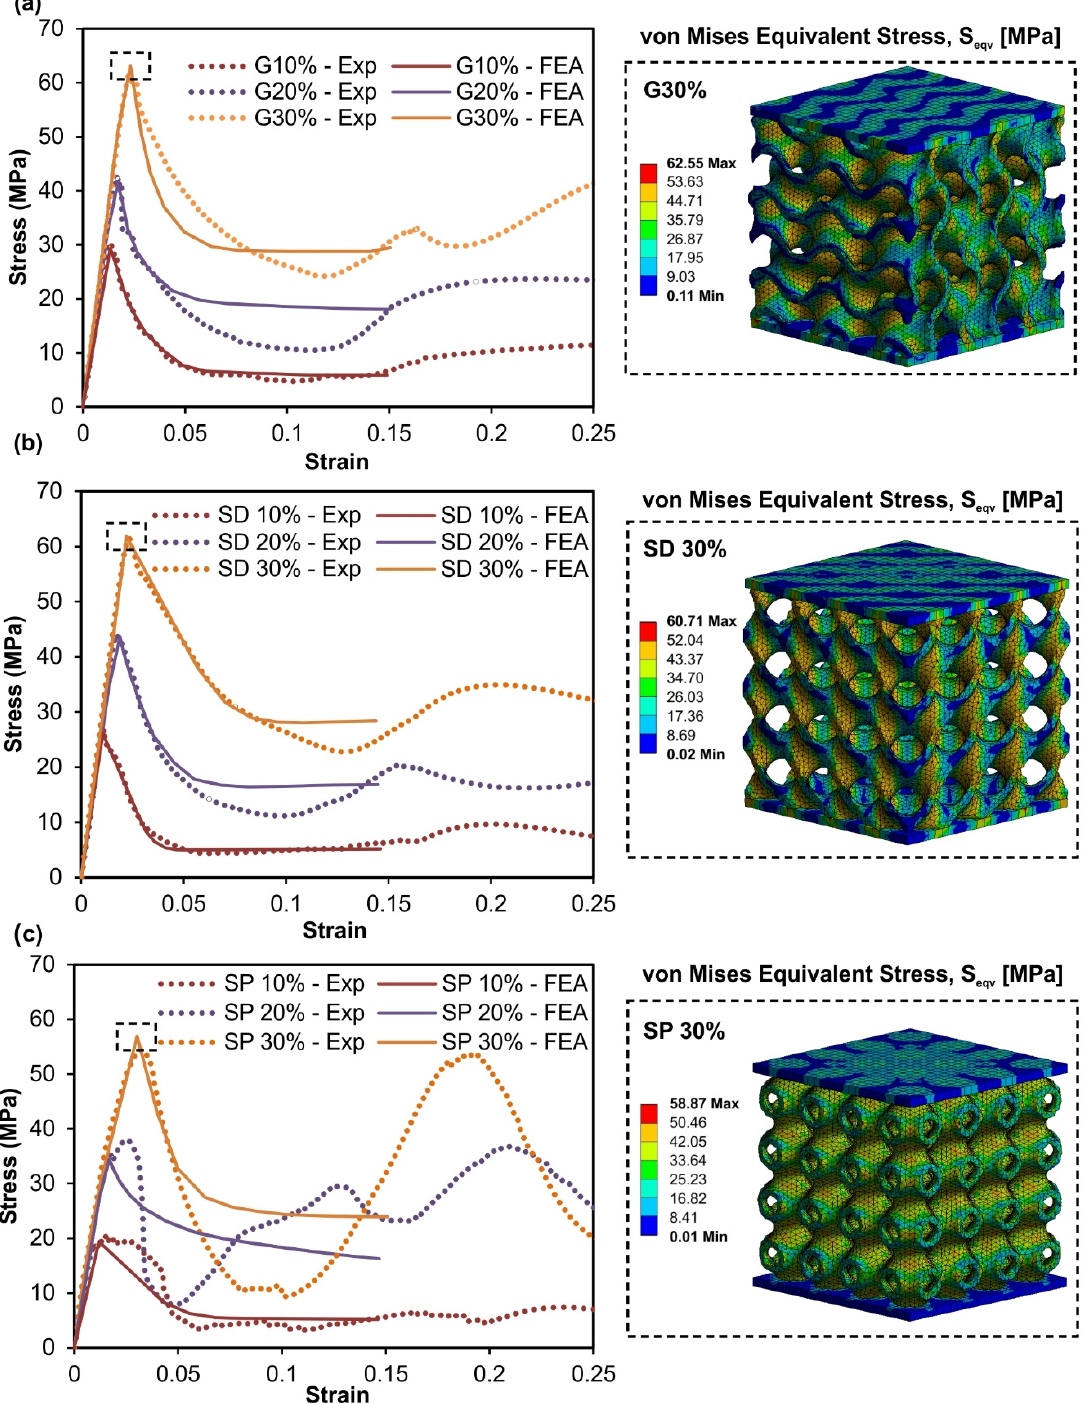
Figure 8. Comparison between experimental and FEA-determined stress-strain curves for ( a ) Gyroid, ( b ) Schwarz Diamond and ( c ) Schwarz Primitive TPMS structures at different relative densities.